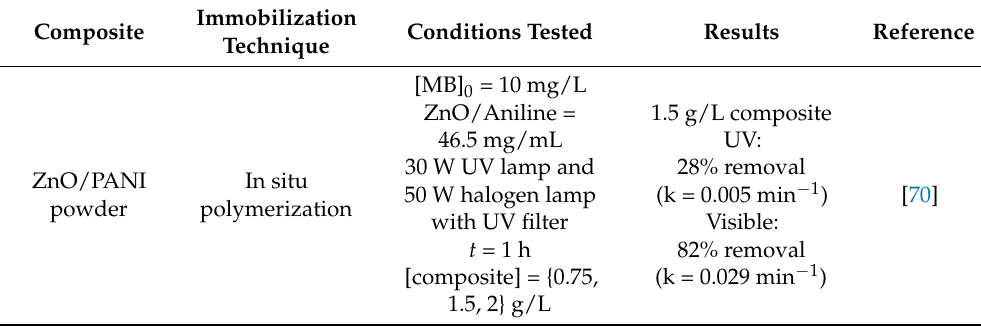
Table 4. Summary of studies that have analyzed the effect of the composite load on the polymer- supported photocatalysis